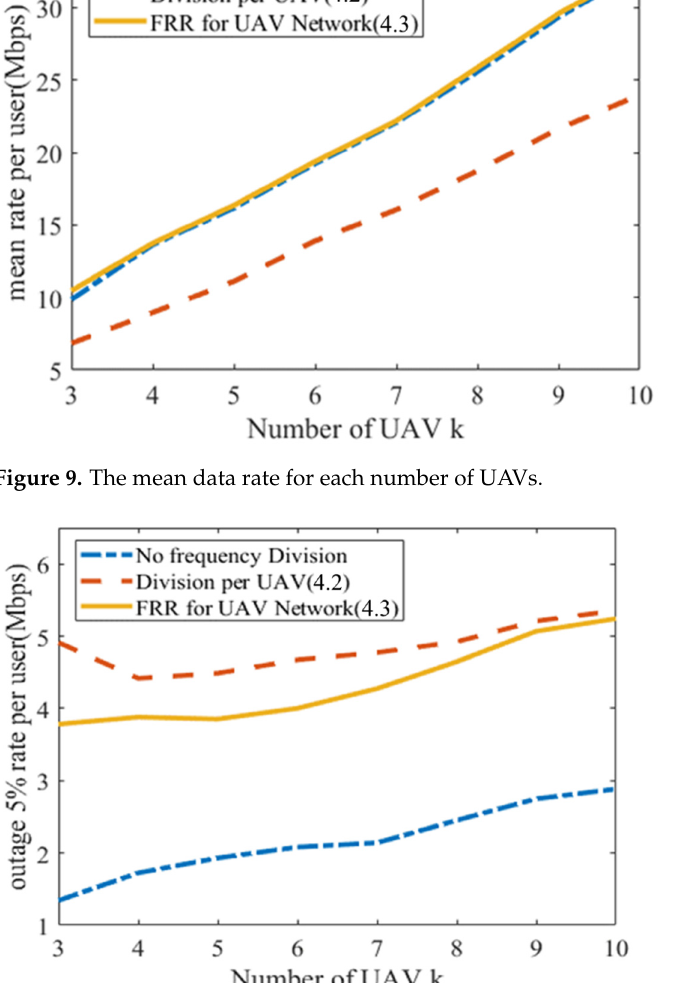
Figure 10. Outage 5% data rate for each number of UAVs.